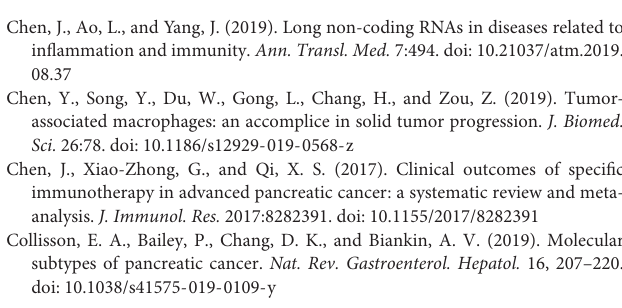
Supplementary Figure 1 | Consensus map of NMF clustering when K = 2–10. Supplementary Figure 2 | Correlation between risk score and clinical